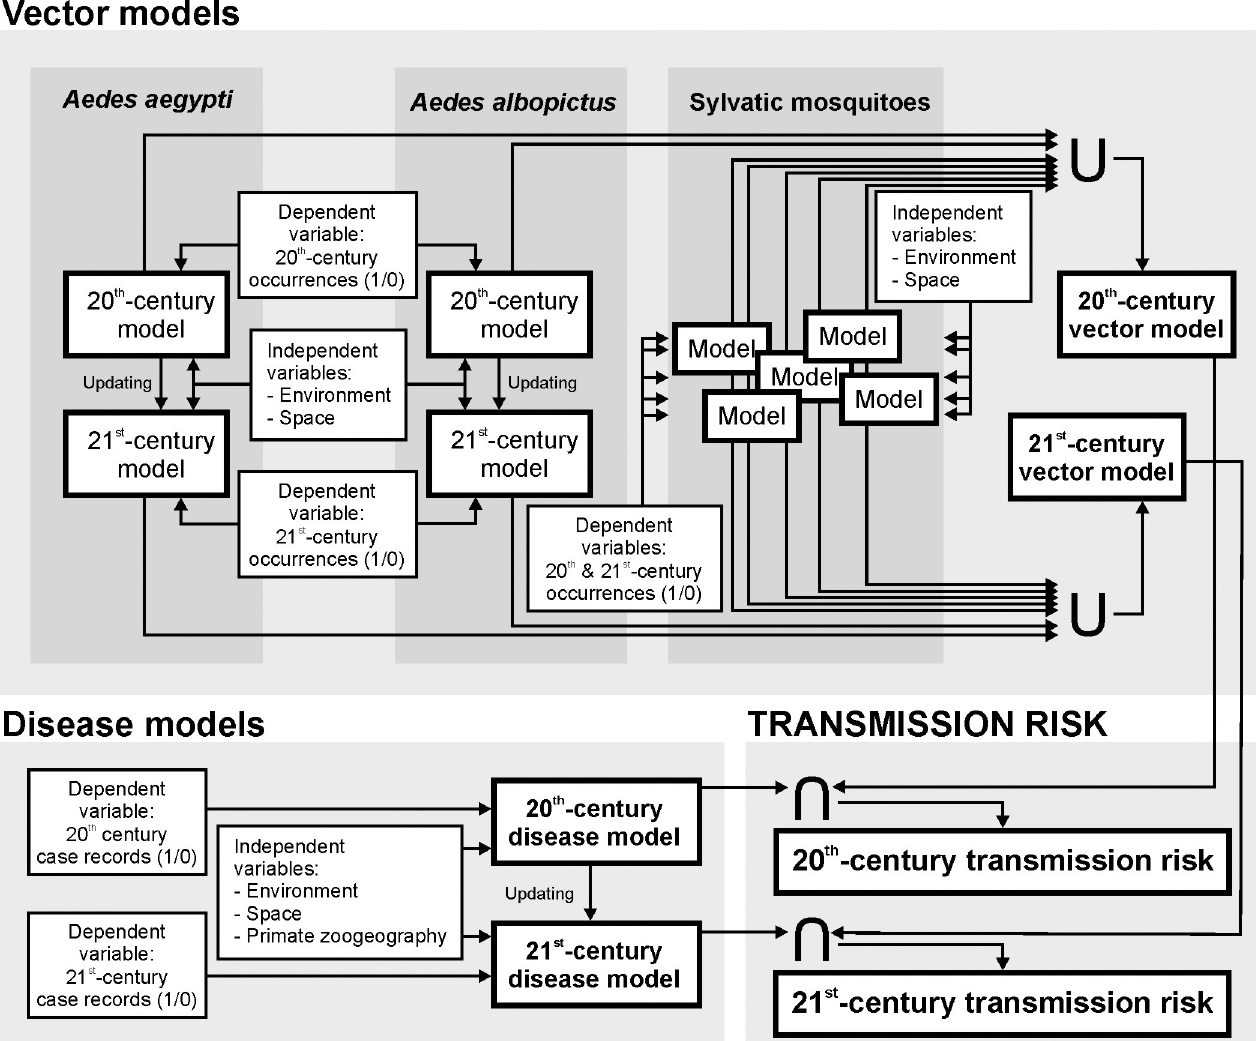
Fig 1. Methodological framework for dengue transmission risk modelling. Vector models result from combining, through the fuzzy union (U), favorable areas for the presence of urban and sylvatic vectors, thus denoting that the presence of one vector species already implies some potential for disease transmission to humans if the pathogen is present. For a given time period and vector species, a vector model is built using mosquito occurrences as dependent variables, and spatial/environmental descriptors as independent predictor variables. Disease models describe the areas favorable to the occurrence of dengue cases, using the presence/absence of dengue-case records as dependent variables, and spatial/environmental/zoogeographic descriptors as independent predictor variables. A temporal stratification differentiating between the late 20 th century and the early 21 st century was applied when the modelled item was subject to a temporally changing dynamic, i.e. to the global distribution of Ae . aegypti , Ae . albopictus , and dengue cases. 20 th -century models were updated by complementing their equations with new variables capable of accounting for the observed changes of distribution. Finally, transmission-risk models quantify the level of dengue-transmission risk, according to the fuzzy intersection ( \ ) between vector and disease models. The intersection reflects that, for dengue to be transmitted in a given location, two elements, acting as limiting factors, must coincide in the area: 1) suitable environmental conditions for disease cases to occur; and 2) suitable conditions for the presence of vectors. Complete methodological descriptions are provided in the main